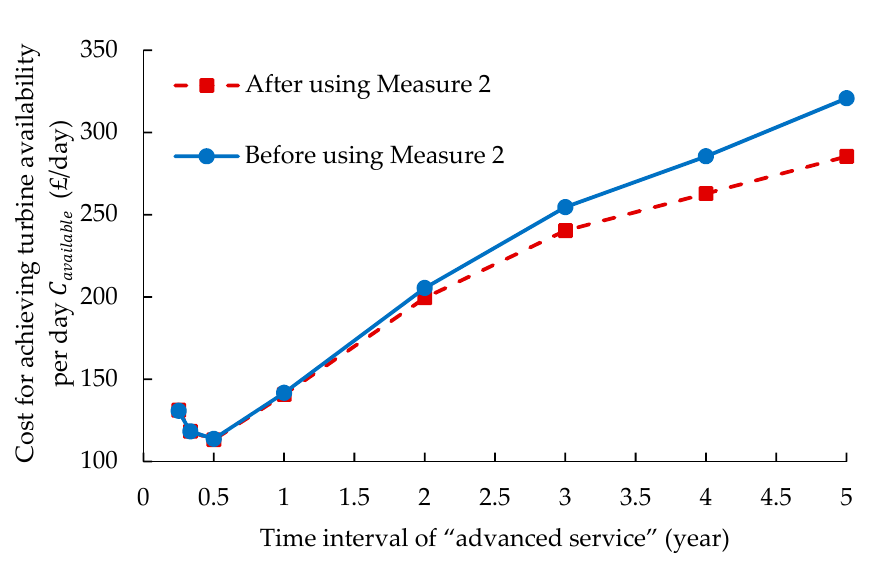
Figure 12. The tendency of Cost for achieving turbine availability per day.